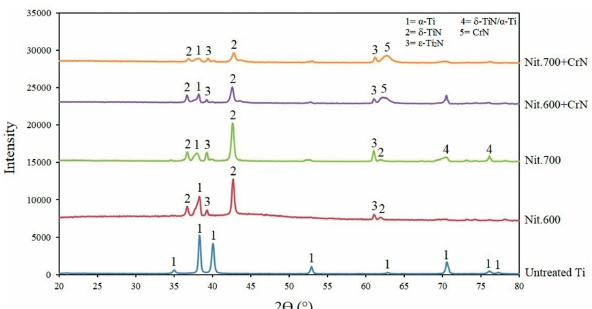
Figure 1: XRD results of the untreated and treated pure titanium